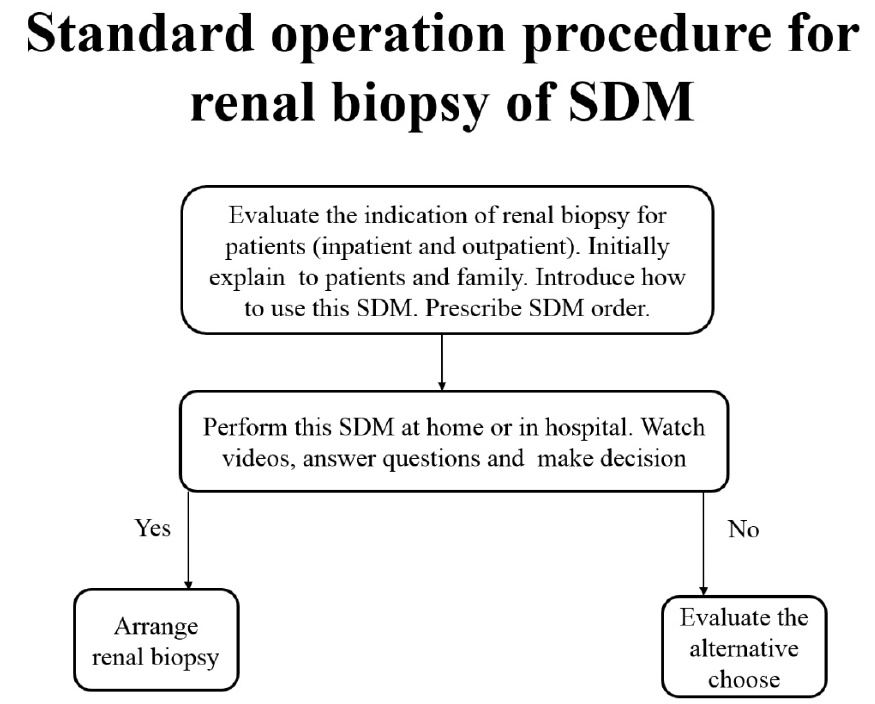
Figure 3. Standard operation procedure for renal biopsy of shared decision making.